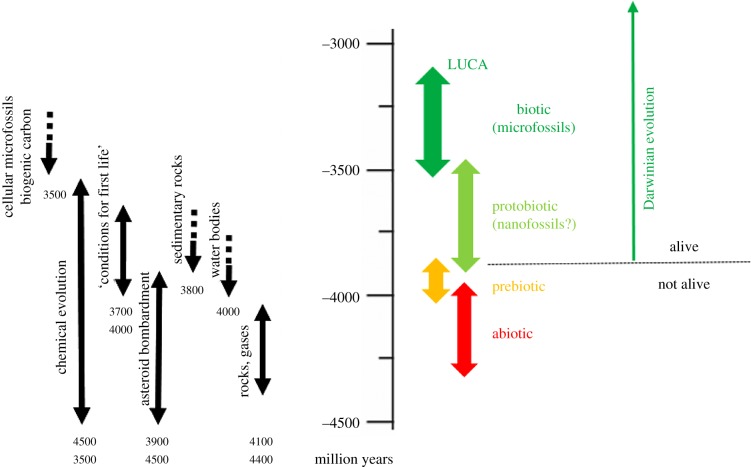
Origin of life as a planetary phenomenon. The geological timing data on the left are from [237]. The abiotic to biotic progression is portrayed with speculative and somewhat arbitrary time demarcations, with some justifications as detailed in the text. The not-alive/alive demarcation is between prebiological and protobiological entities, defined by the emergence of replication and evolution [2]. We note that a different but similarly idiosyncratic demarcation has been proposed [240]. The distinction between ‘abiotic’ and ‘prebiotic’ remains obscure, as indicated by having both appear interchangeably in a paper entitled ‘Abiotic synthesis of RNA in water: a common goal of prebiotic chemistry’ [241]. A possible distinction could be the degree of chemical elaboration: abiotic might relate to non-biological chemical processes that convert inorganic compounds or very simple organic compounds to somewhat more complex organic molecules, while prebiotic possibly more related to non-biological processes involving higher non-covalent or covalent complexity, sometimes necessitating external catalysis. The terms protobiotic, as exemplified in §12, addresses entities such as replicating RNA molecules or mutually catalytic sets, capable of rudimentary self-replication. More elaborate, membrane-enclosed replicating entities that are sufficiently large and durable to be detected as cell-like microfossils are termed here as biotic. We note that future technologies would perhaps be able to identify the much simpler and smaller protobiological ‘nanofossils’. Early biotic entities would likely be very different from LUCA, the last universal common ancestor of today's biota. Reaching this ultimate milestone has been described as ‘a long long way to LUCA’ [240, p. 4]. Every step in the passage from early protobiotic entities must have occurred, by definition, through Darwinian evolution.